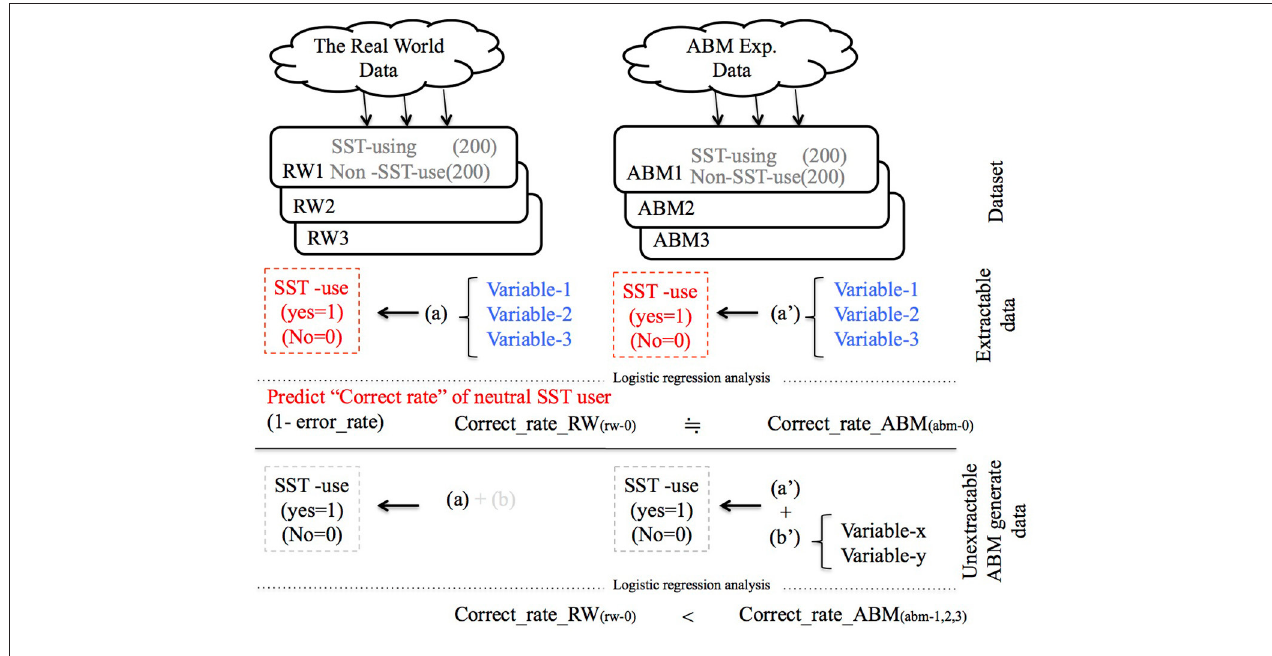
FIGURE 5 | Framework of